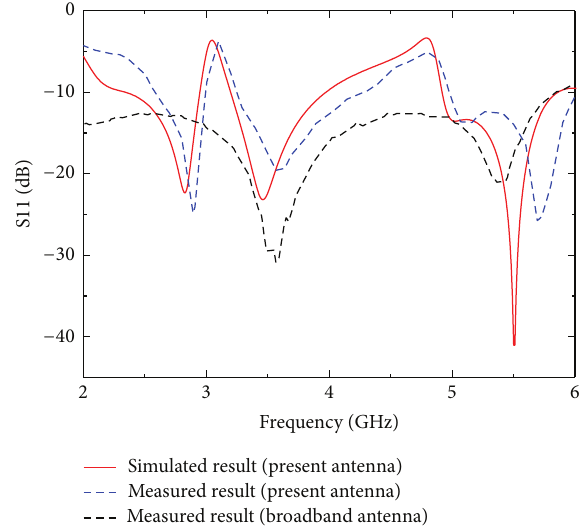
Figure 1: Configuration of the presented antenna (units in mm) ( 𝐿1 = 10mm, 𝐿2 = 4.5 mm, 𝐿3 = 11.5 mm, 𝐿4 = 7.5mm, 𝐿5 = 6.9 mm, 𝐿6 = 2.5 mm, 𝐿7 = 9 mm, 𝐿8 = 4 mm, Ra = 8.2 mm, 𝑊1 = 0.5 mm, and 𝑊2 = 0.5 mm).